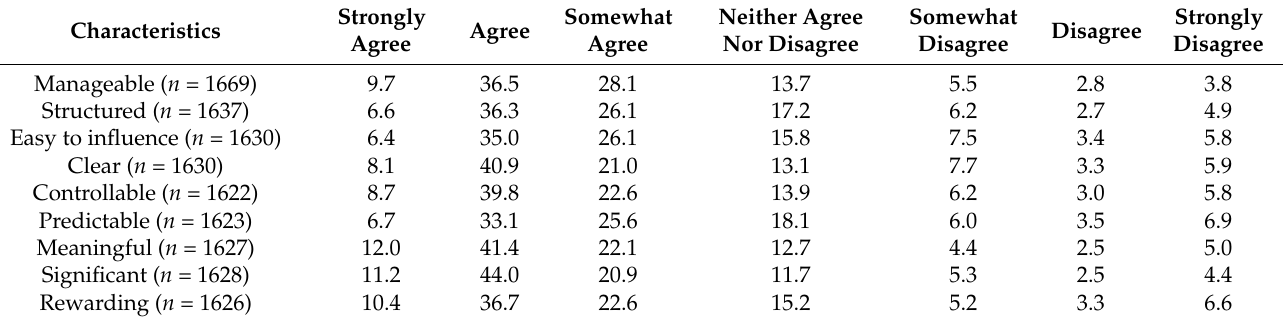
Table 2. Percentage distribution of sense of